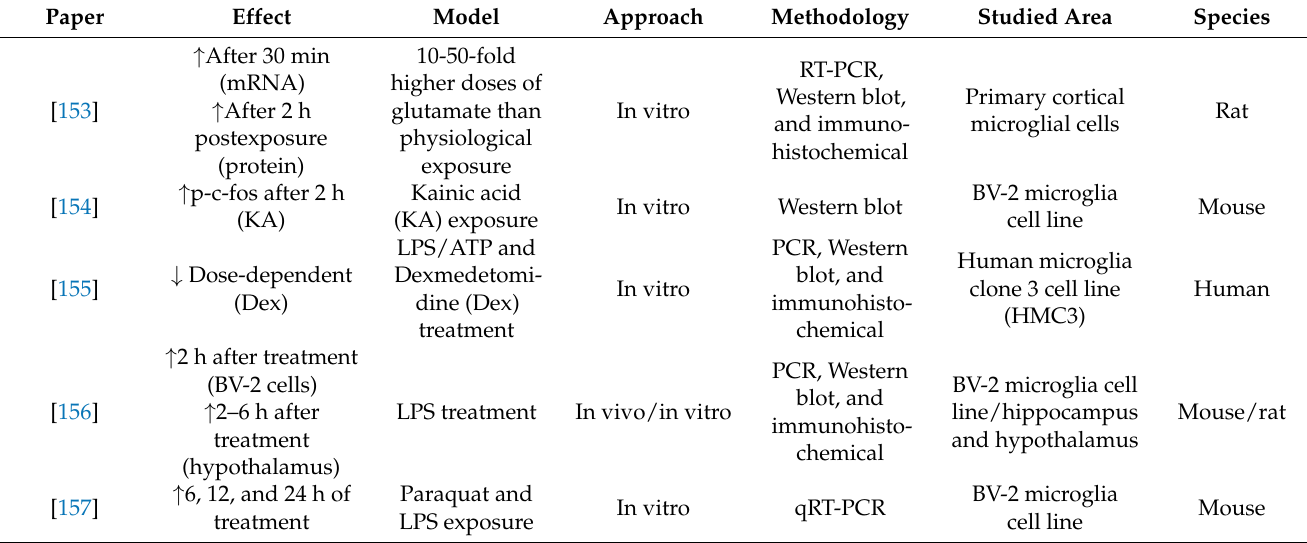
Table 3. Papers evidencing c-fos expression in